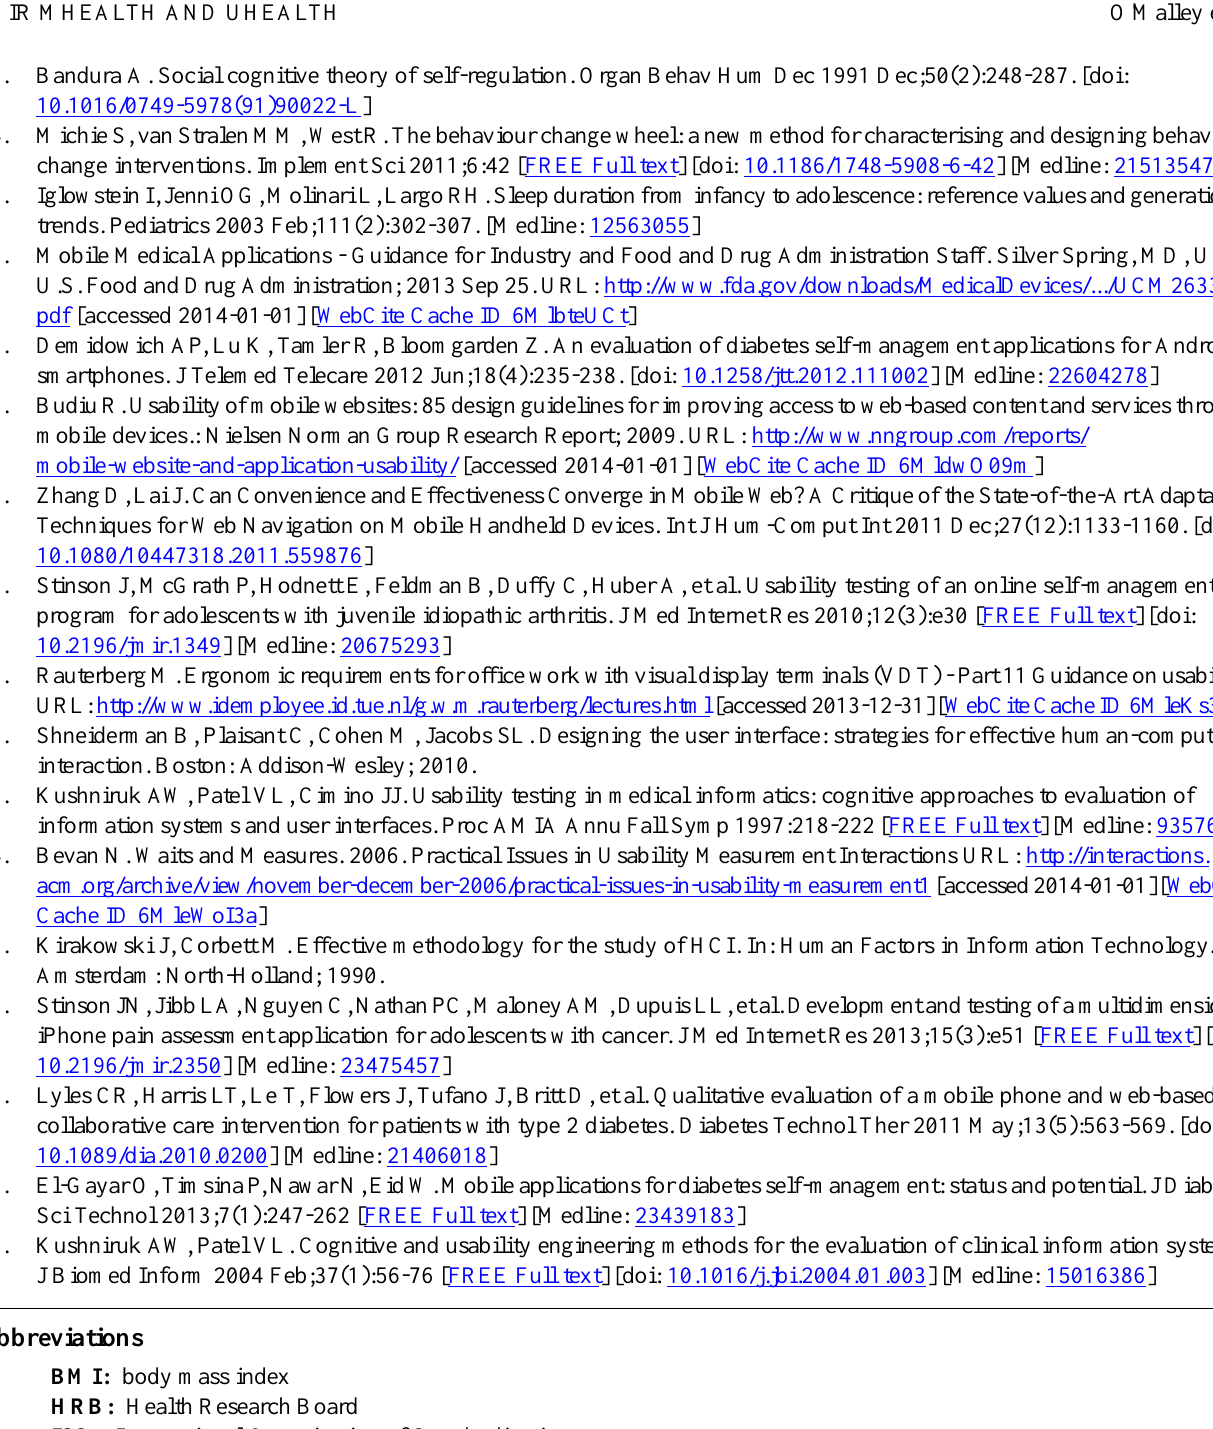
RUS: relative user efficiency score SUMI: standardized software usability measurement